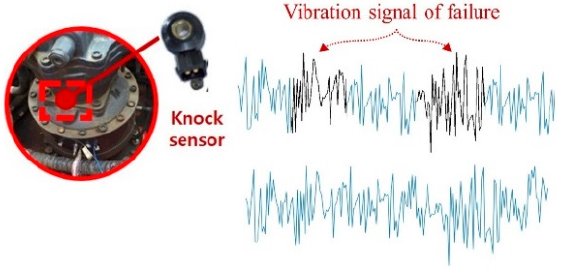
Figure 1. Sensor mounting location and measurement vibration signals. Table 1. The specification of the knock sensor used in actual machines.